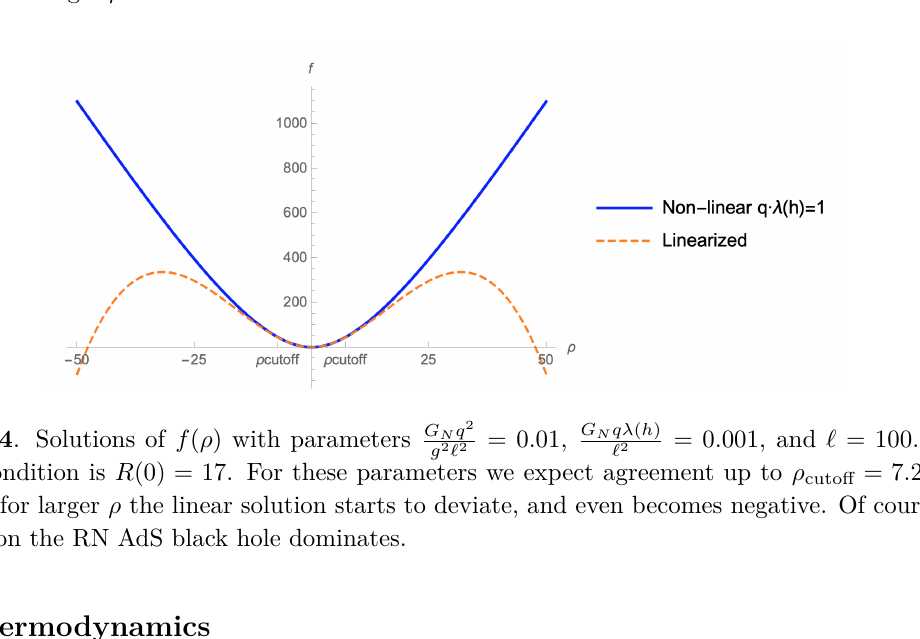
Figure 3 . Solutions of R ( ρ ) with parameters G N q 2 initial condition is R (0) = 17 . For these parameters we expect agreement up to ρ cutoff = 7 . 2 . We see that for larger ρ the linear solution starts to deviate.